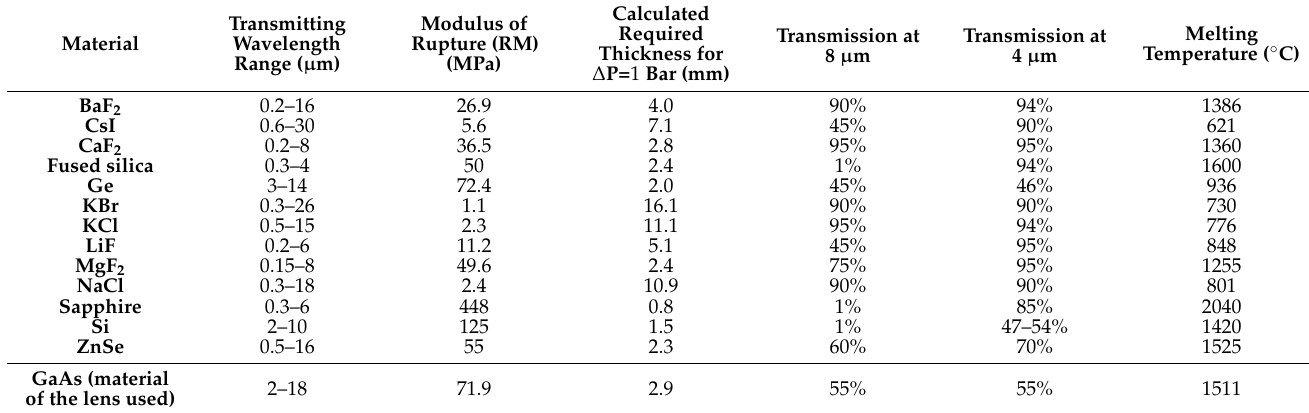
Figure 3. The IR transmittance of barium fluoride as a function of wavelength and thickness of the window (elaborated from [31]). Table 2. Properties of various IR transmitting materials (transmitting wavelength elaborated from [32], transmission at 8 and 4 µ m as well as melting temperature are elaborated from